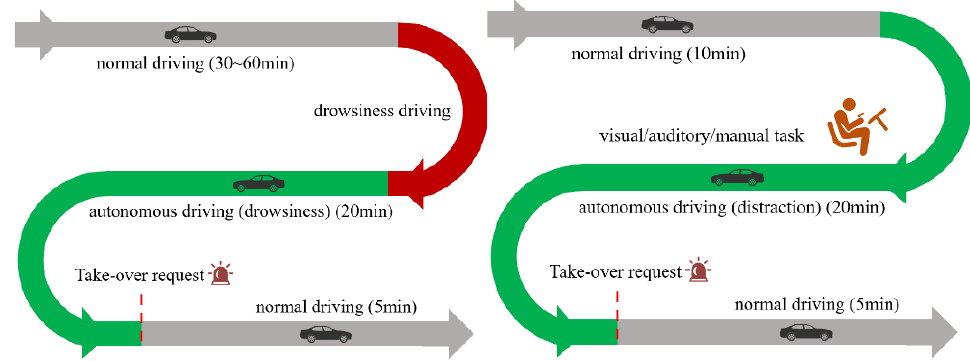
Figure 3. Driving scenarios involving the driver being drowsy and distracted.